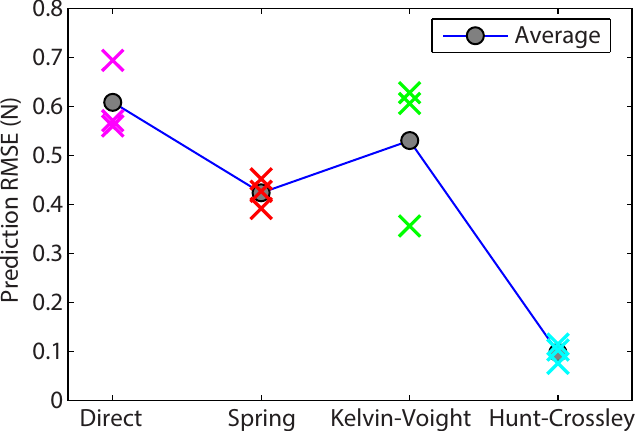
Figure 16. Prediction RMSE for each of the force feedback methodologies